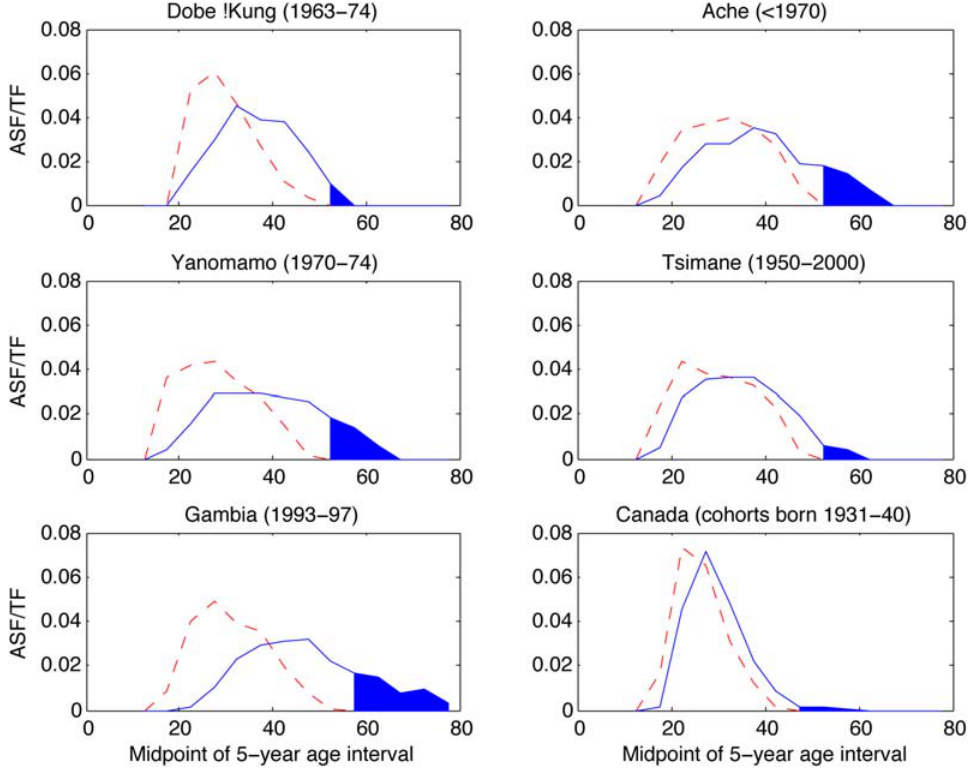
Figure 2. Observed distributions of female and male fertility. Fertility distributions (in age-specific fertility rates as a fraction of total fertility rate) for women (dashed red) and men (solid blue) for ( a ) the hunter-gatherer Dobe !Kung of Botswana, ( b ) the forest-living Ache, ( c ) the Amazonian forager- horticulturalist Yanomamo, ( d ) Bolivian forager-horticulturalists the Tsimane, ( e ) agricultural Gambian villagers, ( f ) modern Canada. The blue shaded area represents realized male fertility after the age of last female reproduction.